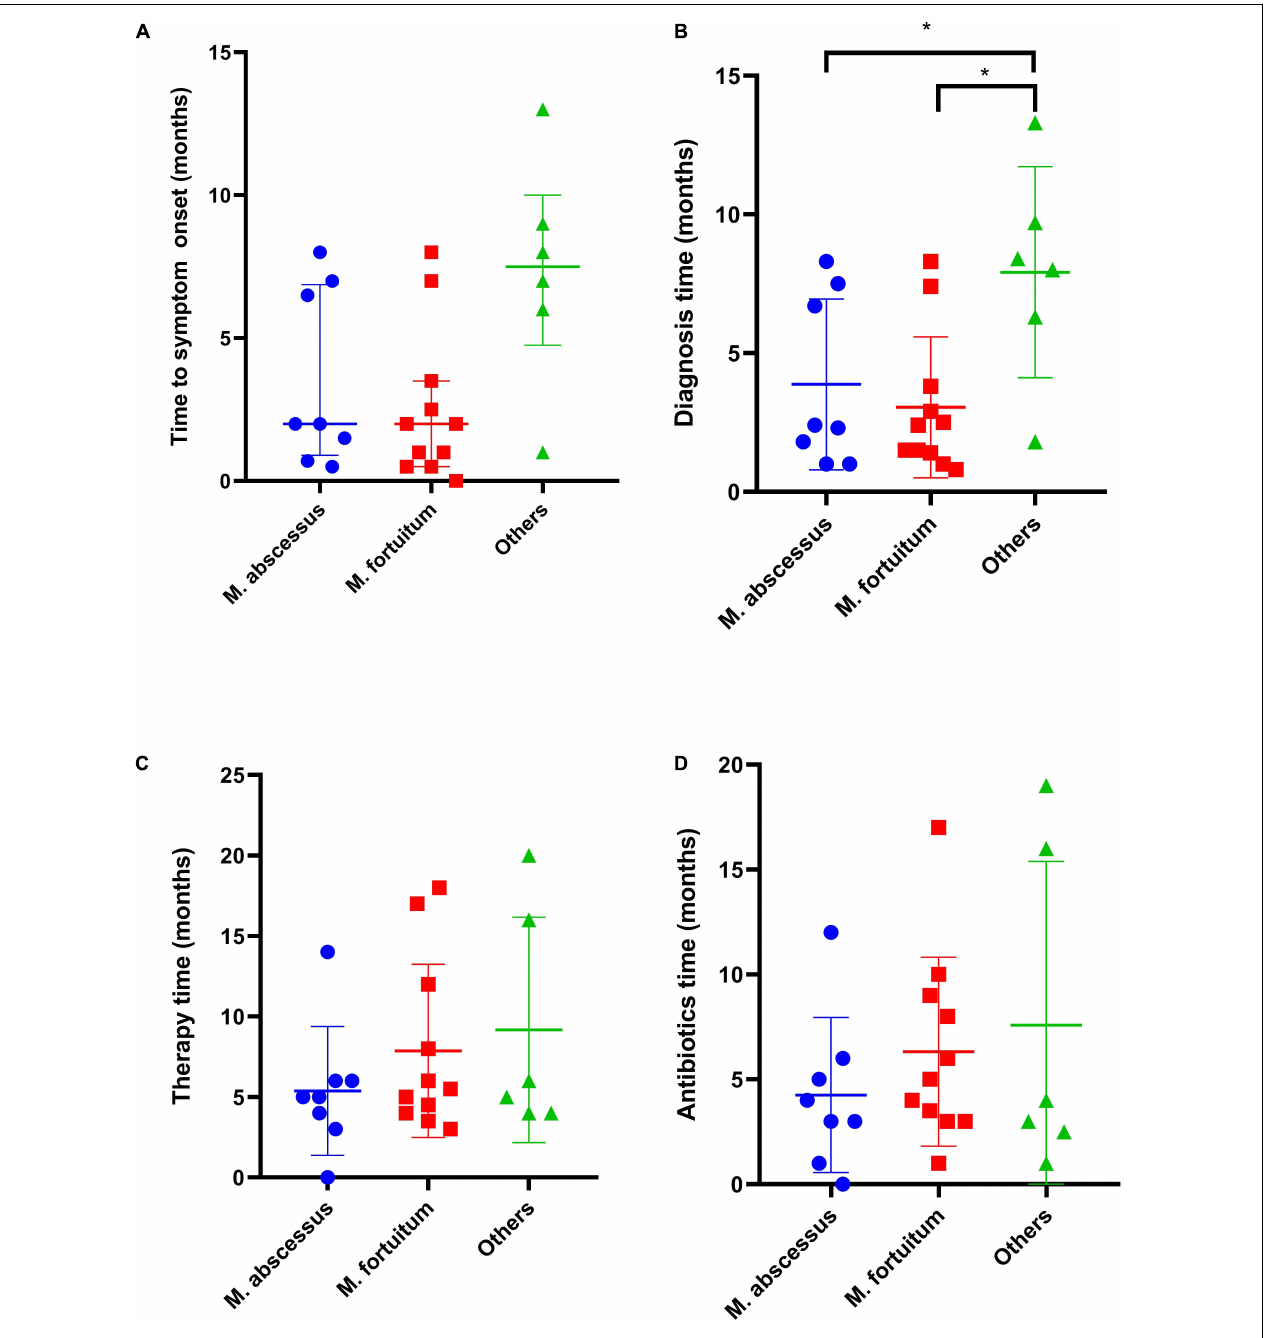
FIGURE 1 | Comparison of clinical manifestations and duration of therapy for M. abscessus ( n = 8), M. fortuitum ( n = 11), and others ( n = 6). (A) Time to symptom onset, (B) Time from symptom onset to diagnosis, (C) Total duration of therapy, months, and (D) Time from last infection control surgery to cessation of antimicrobial therapy, months. * p <